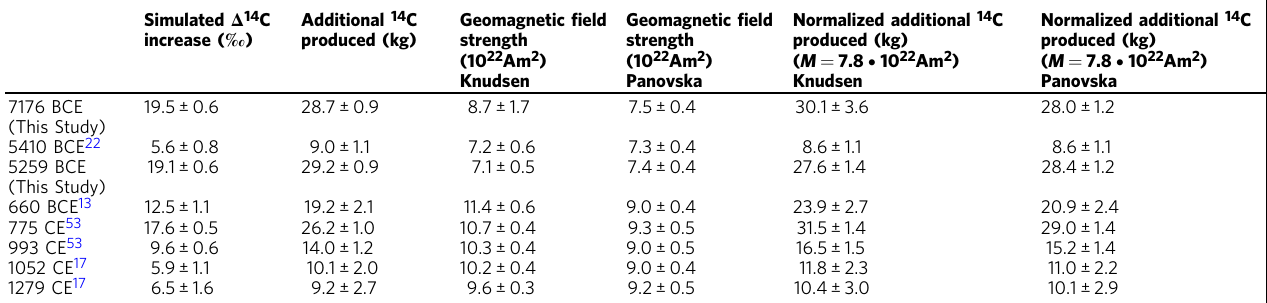
Table 1 The modeled atmospheric 14 C increases, produced 14 C and normalized 14 C produced at the modern earth magnetic fi eld is given for new and known